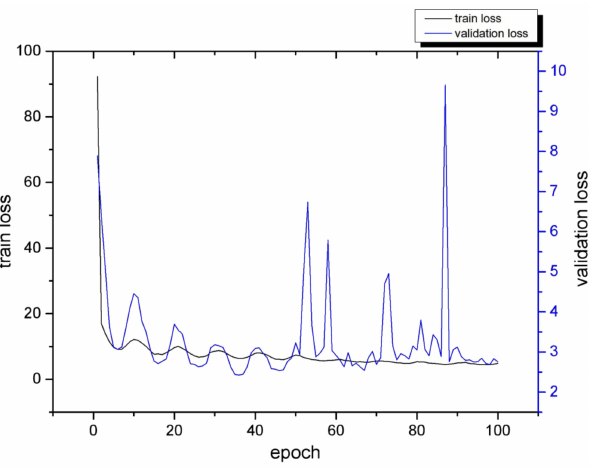
Figure 7. Model loss curves for different